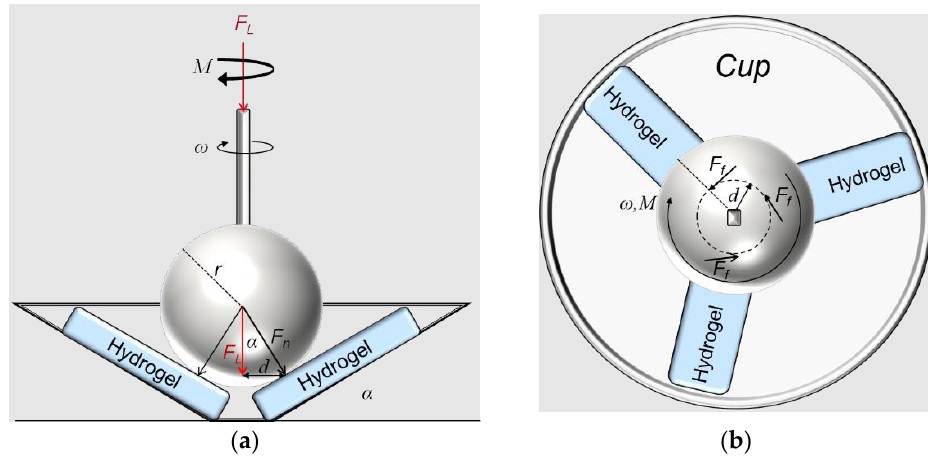
Figure 1. Schematic ( a ) side and ( b ) top views of the ball-on-three-plates tribology test. The shaft applied a load of F L on the probing ball that made contact with three hydrogel samples. Three hydrogel samples of 15.5 × 6 × 3 mm dimensions were mounted on inclined surfaces and radially positioned at equal 120° angular intervals in a circular cup. The shaft applied a load that transferred normal force F N on each of the three